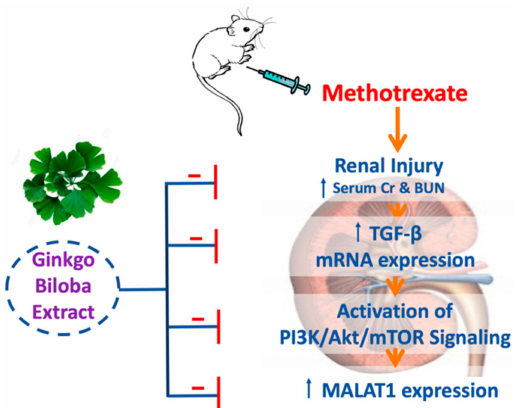
Figure 6. A diagram illustrating the proposed nephroprotective mechanism of GB in a model of nephrotoxicity induced by